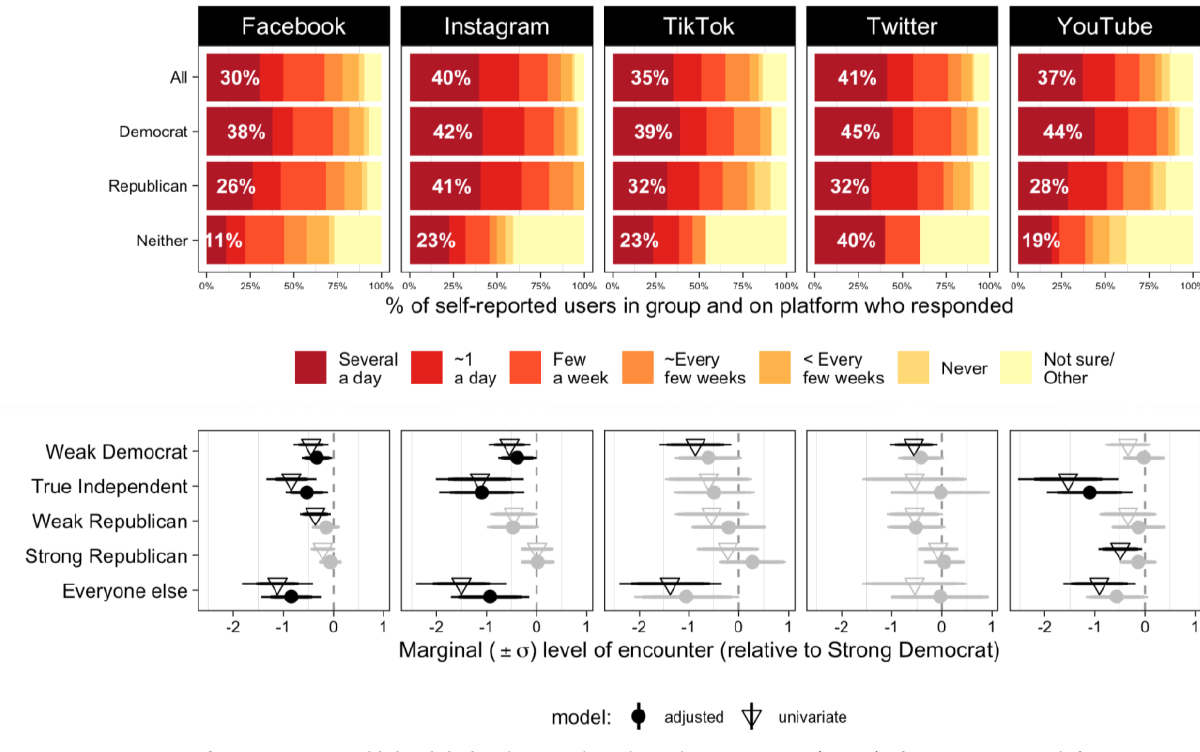
Figure 1. Frequency of exposure to credibility labels. The top plots show the percentage ( x- axis) of responses in each frequency category (colored bar) for each respondent group ( y -axis) and social media platform (columns) . The “Neither” respondent group includes True Independents (identified via an explicit response), non-responders, and third-party affiliates. The bottom row of plots shows estimated standardized differences in the level of exposure between the different partisan groups using a simple t -